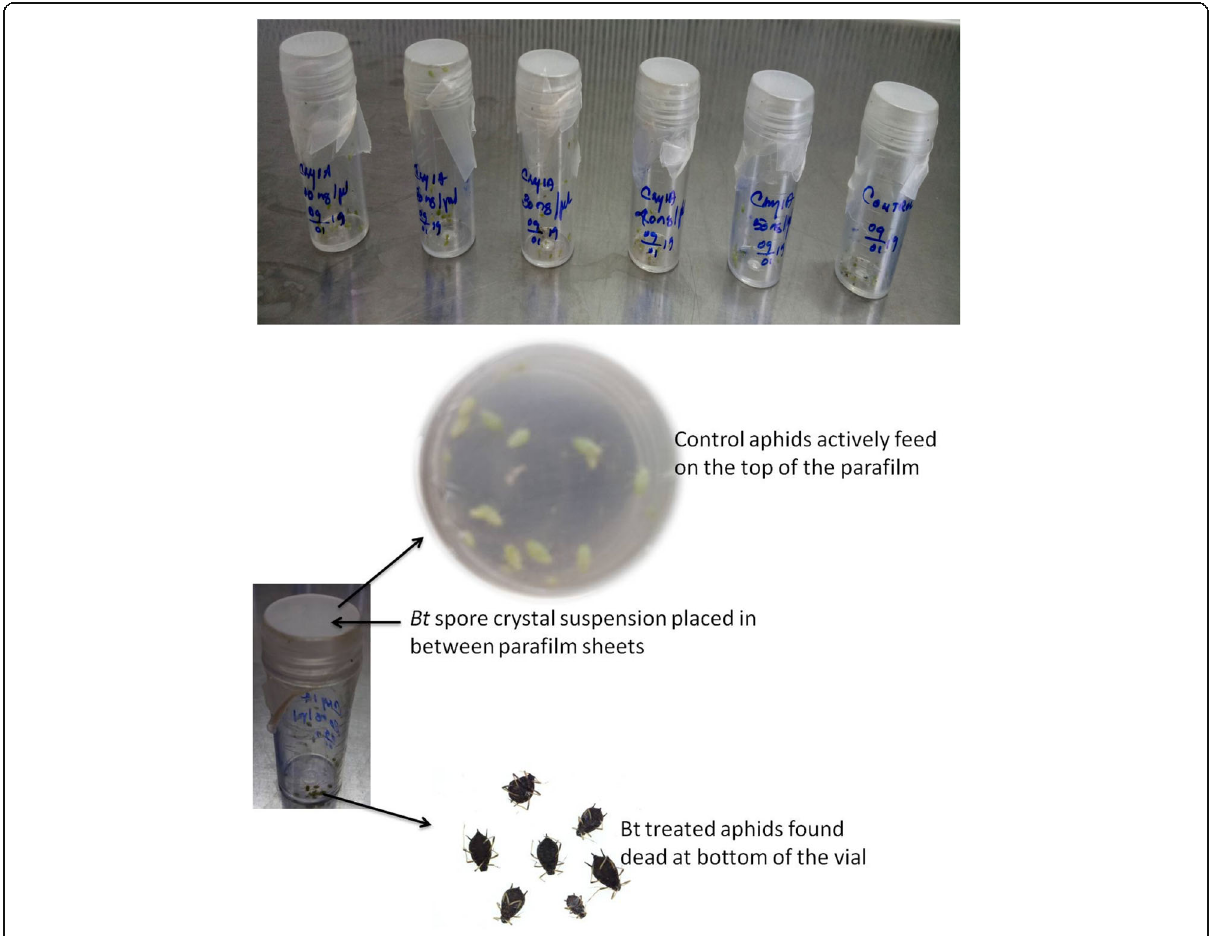
Fig. 1 Setting up of vials for bioassay Bt spore crystal suspension against aphids. Bioassay of aphids and with Bt crystal suspension in the treatment vial and another vial was given normal water instead of Bt crystal suspension as a control for